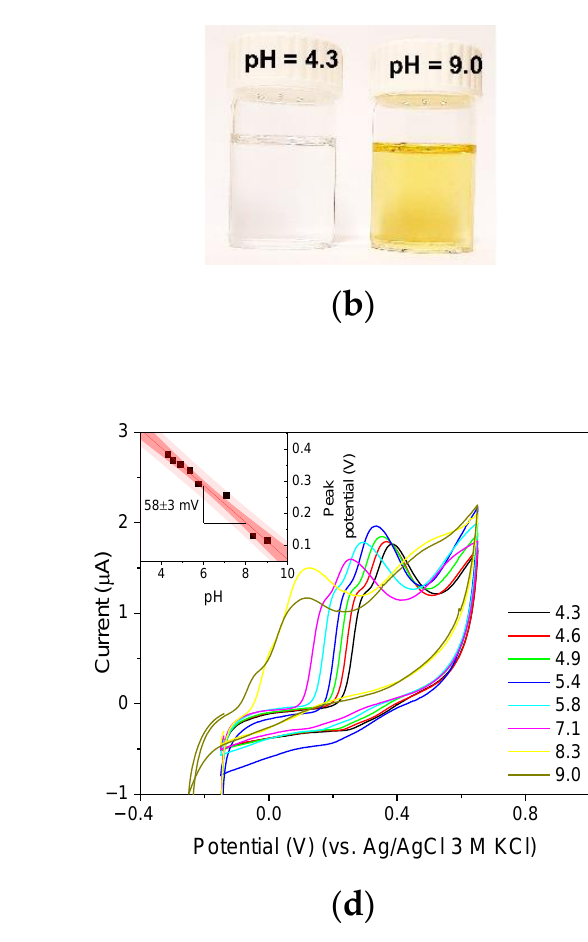
Figure 9. ( a ) Photograph of the solutions before testing: (GT1, GT2) infusion of Camellia sinensis (two brands) and (SC) Salvia sclarea , (SP) extract of a dietary supplement and (HD) hydrolat. ( b ) Photograph of the 0.1 mM solution of epigallocatechin gallate with pH 4.3 and 9.0. ( c ) Cyclic voltammo- grams recorded in 200 times diluted extracts using GC n /PDMS carbon paste electrodes in 0.1 acetate buffer (pH = 4.5) at a scan rate of 100 mV/s. ( d ) Cyclic voltammograms recorded in 0.1 mM solution of epigallocatechin gallate in 0.1 acetate buffer of different pH using a GC n /PDMS carbon paste elec- trode at a scan rate of 50 mV/s. Inset: The dependence of epigallocatechin peak potential on pH. Table 2. Summary of physicochemical and electrochemical parameters of samples.